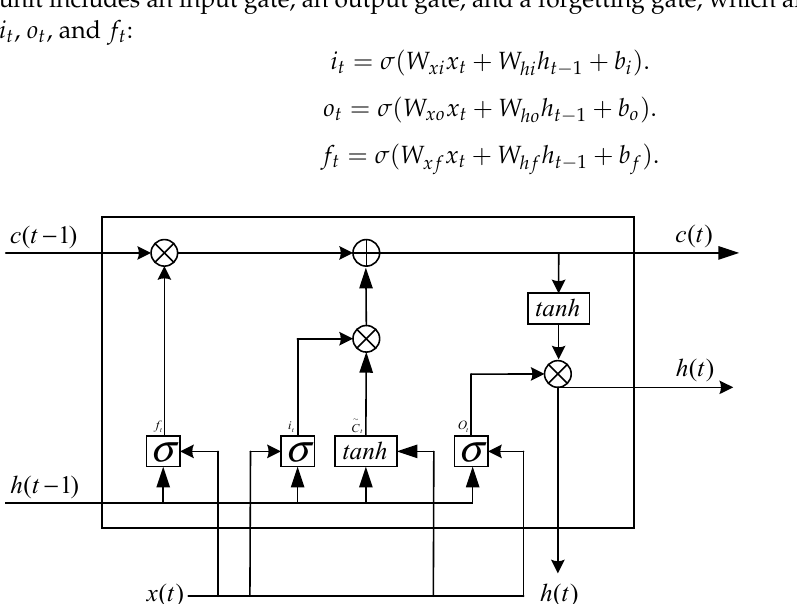
Figure 3. Hidden layer unit of the LSTM.